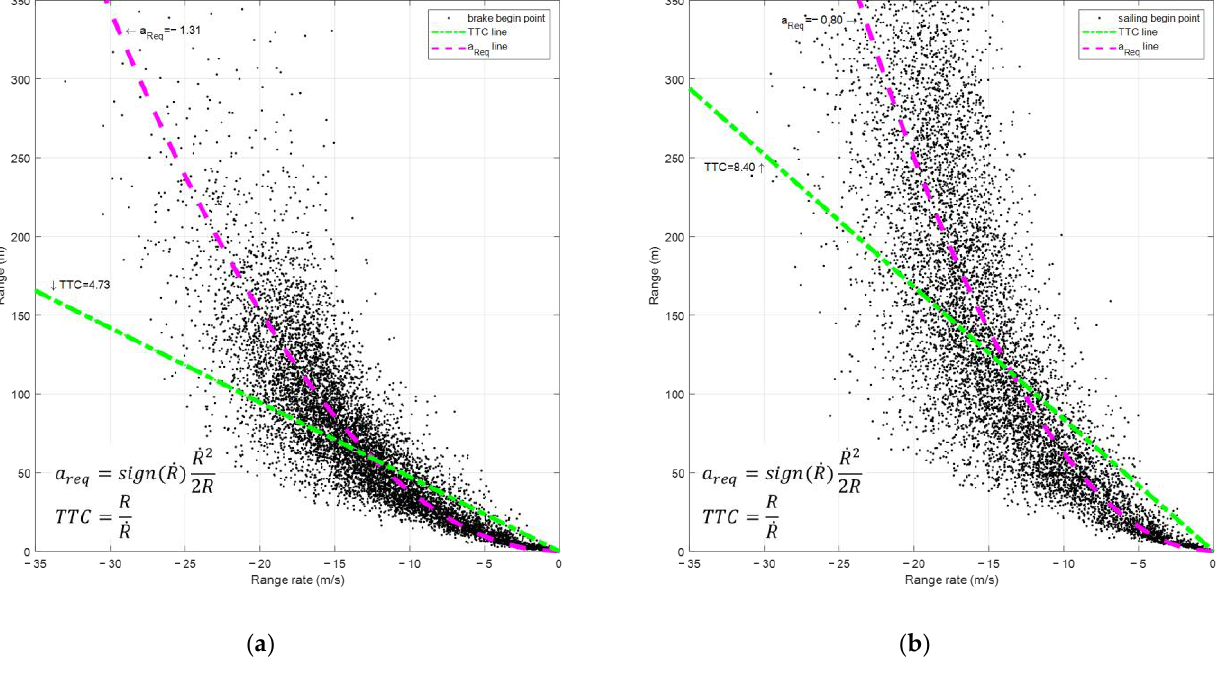
Figure 8. Distributions of braking/sailing start point w.r.t. relative distance/velocity: ( a ) the case of the braking start point; ( b ) the case of the sailing start point.